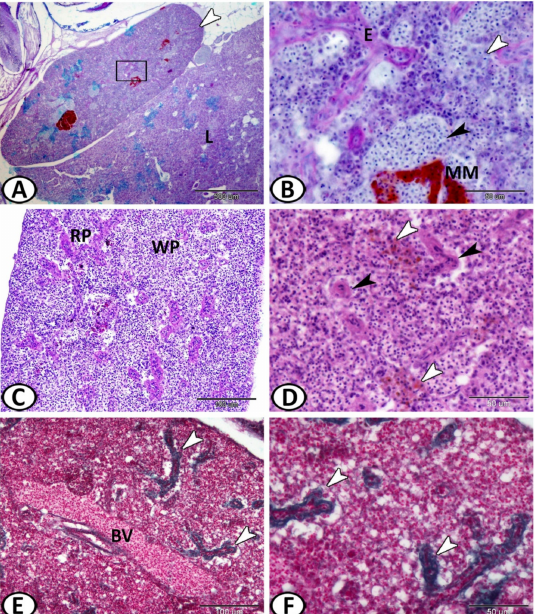
Figure 1. ( A ) General view of the spleen (white arrowhead) of molly fish found adjacent to the liver (L) and showing the distribution of melanomacrophage centers (red color) (AB/HX). ( B ) Higher magnification of the boxed area shows white pulp (white arrowhead), the red pulp (black arrowhead), ellipsoids (E), and melanomacrophage center (MM) (AB/HX). ( C ) The parenchyma of the spleen of Molly fish consists of white pulp (WP) and red pulp (RP) (PAS/HX). ( D ) Ellipsoids (black arrowheads) and melanomacrophage center (white arrowheads) (HE). ( E , F ) Ellipsoids (white arrowheads) are the termination of splenic arterioles. Note a large blood vessel (BV) (Crossmon’s